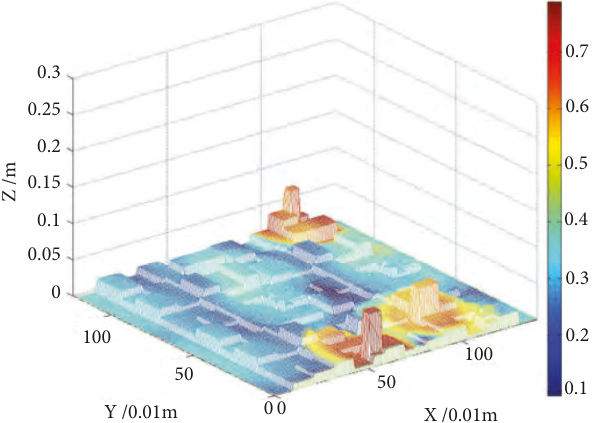
Figure 12: Cost map of the 3D terrain.